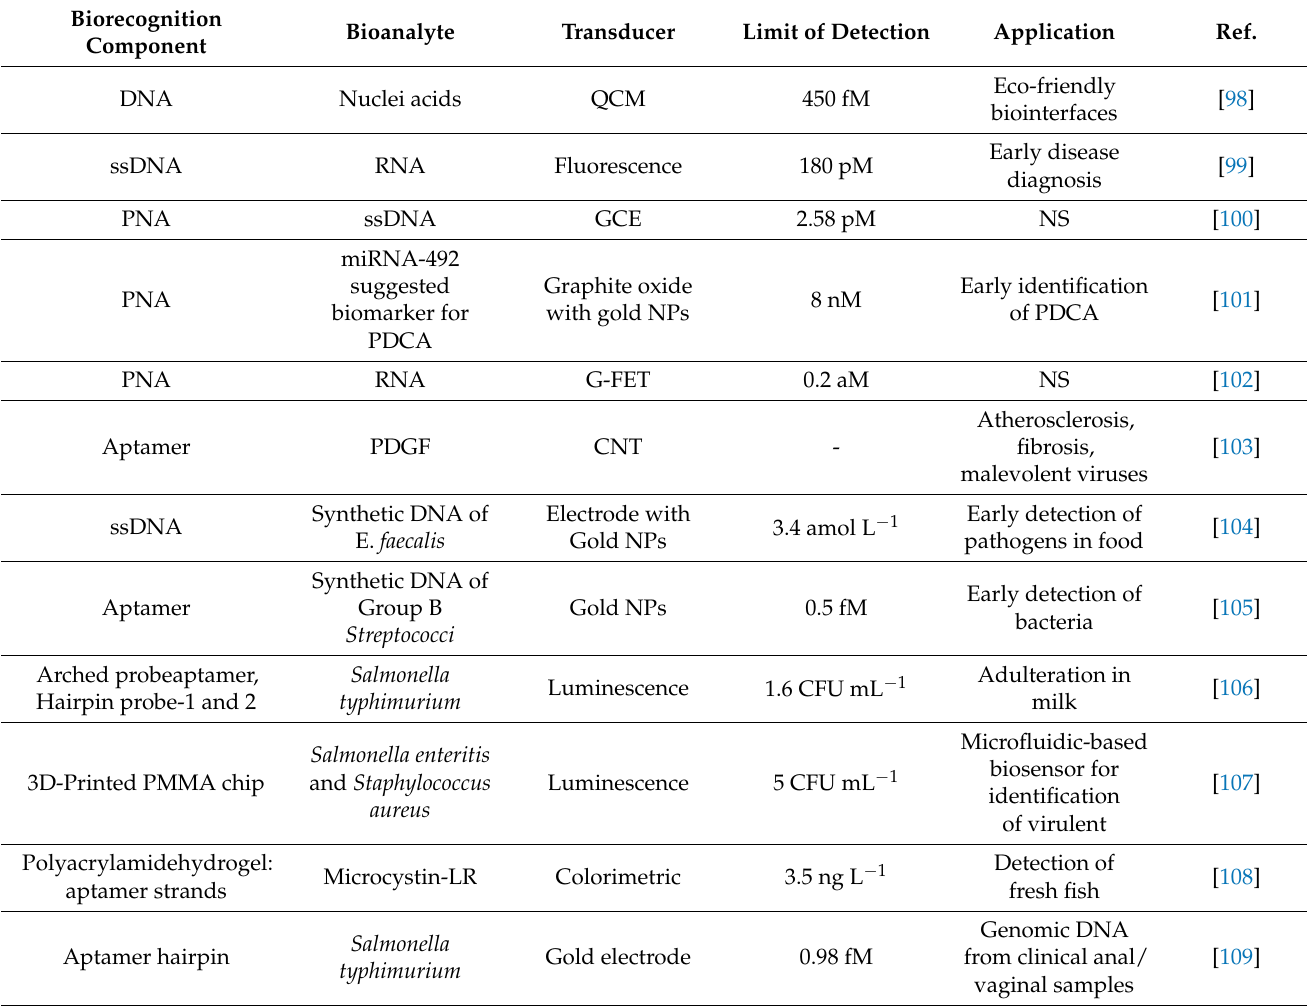
Table 2. Summary of performance characteristics for the various nucleic acid